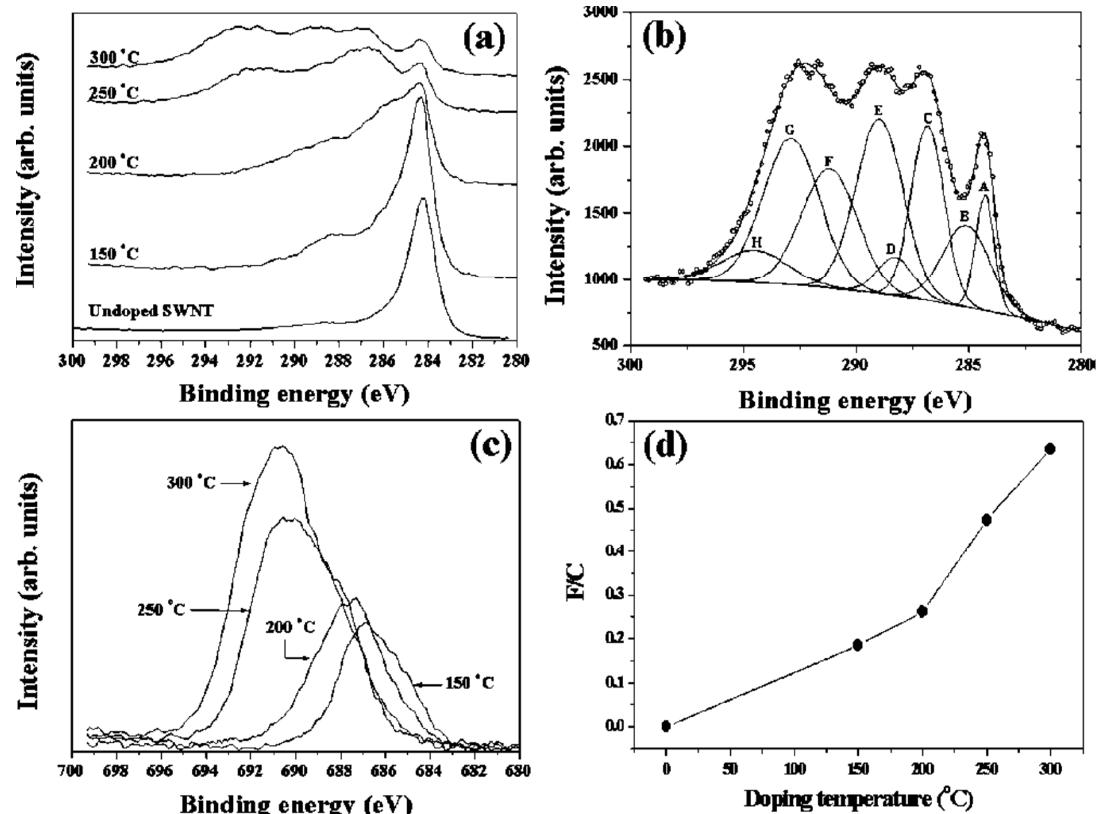
Figure 4. ( a ) C 1s XPS spectra of pristine SWCNTs and SWCNTs fluorinated at 150, 200, 250 and 300 °C. ( b ) Gaussian peak fitting of the C 1s XPS spectra of the SWCNTs after fluorination at 300 °C. The individual peaks are due to sp 2 (A), sp 3 (B), oxygen bonds (C–E) and fluorine bonds (F–H). ( c ) F 1s XPS spectra of the same fluorinated SWCNTs. ( d ) Atomic F/C ratio versus fluorination temperature Reprinted with permission from Ref. [47]. Copyright 2002 Elsevier.